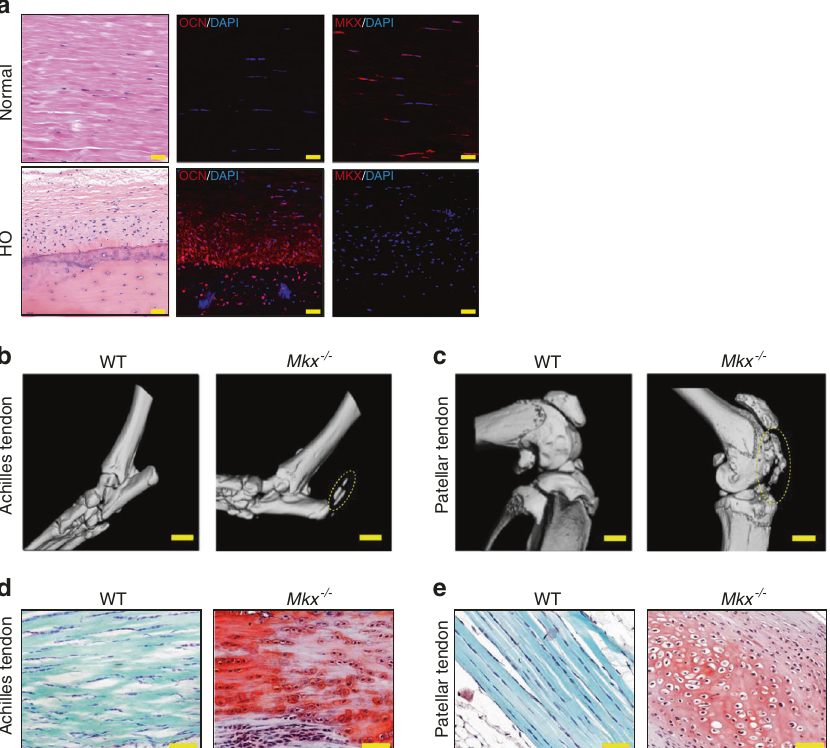
Fig. 1 Mkx de fi ciency causes tendon heterotopic ossi fi cation. a HE (left) and immuno fl uorescence staining of OCN (middle) and MKX (right) in the tendons of normal individuals and HO patients. Scale bar, 50 μ m. b, c Micro-CT examination of Achilles tendons ( b ) and patellar tendons ( c ) from WT and Mkx − / − mice. Scale bar, 1 mm. d, e Safranin O-Fast green staining of Achilles tendons ( d ) and patellar tendons ( e ) from WT and Mkx − / − mice. Scale bar, 50 μ (dotted circles in Fig. 1c and Supplementary Fig. S1). To further upregulated expression of proangiogenic genes in all tendon con fi rm the HO phenotype in Mkx − / − tendons, we performed cell clusters. Inhibition of angiogenesis by the small molecule BIBF1120 attenuated bone formation and angiogenesis in both the Mkx − / − mouse degenerative HO model and the rat traumatic model of HO.